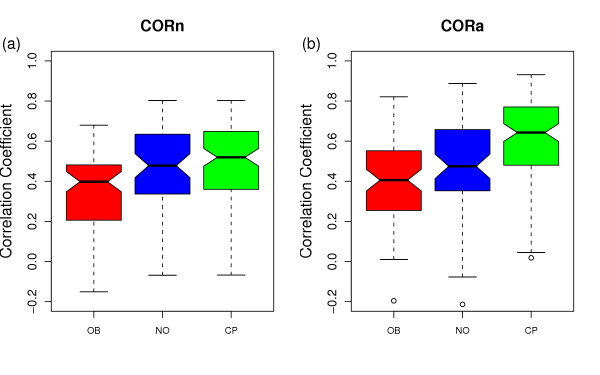
Boxplot of correlation coefficients between amino acid compositions of interface and protein surface for the BNCP-CS dataset, calculated using number-based composition (a) and area-based composition (b).